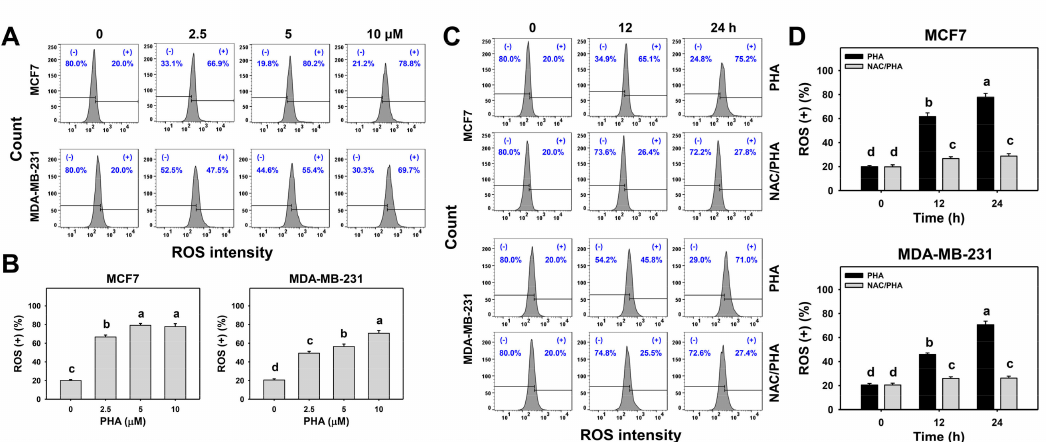
Figure 4. PHA triggered ROS generation in two breast cancer cell lines. ( A , B ) ROS patterns and statistical analysis for concentration responses to PHA. Cells were incubated with PHA (0 (0.05% DMSO as control), 2.5, 5, and 10 µ M) for 24 h. (+) indicates ROS (+) (%). ( C , D ) Pattern and statistical analysis for NAC pretreatment responses in ROS intensity changes in PHA-post-treated breast cancer cells. Following pretreatment with NAC, cells were processed with post-treatment with 0 (control with 0.05% DMSO) and 10 µ M PHA for 0, 12, and 24 h, i.e., PHA and NAC/PHA. Data, means ± SDs ( n = 3 independent experiments). Experiments without the same top-labeled letters indicate significant changes according to multiple ANOVA comparison ( p < 0.05 to 0.0001).